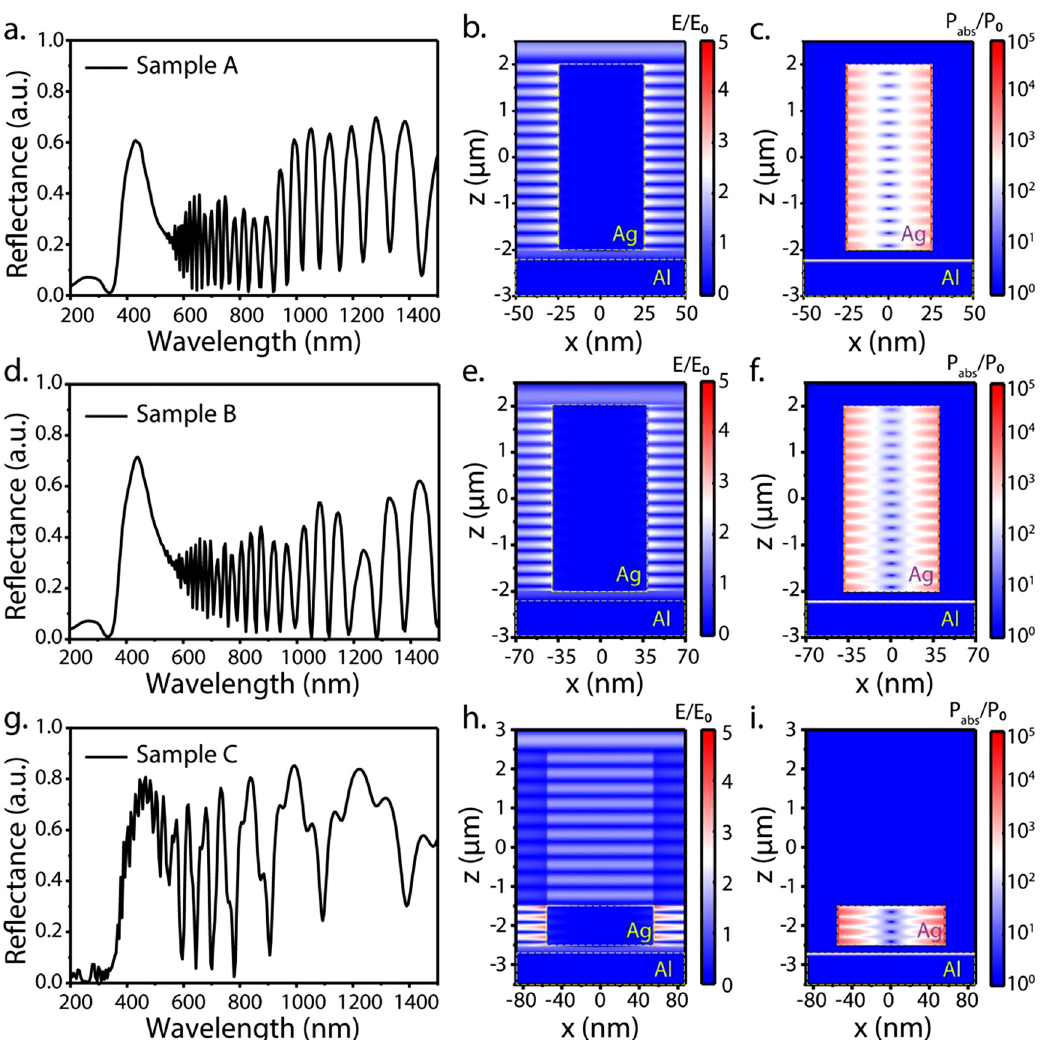
Figure 3: The simulated reflection spectra of the APA-AAO samples with the same structure parameters of the Sample A (a), B (d), and C (g), respectively; (b), (e), and (h) The electric-field distribution at excited wavelength of 1064 nm with respect to the left re fl ection spectra; (c), (f), and (i) The electromagnetic energy consumption distribution extracted from the electromagnetic fi eld distribution shown left. The inset dashed line indicates the Ag pillar and the Al foil material area, and the left area is the material of Al 2 O 3